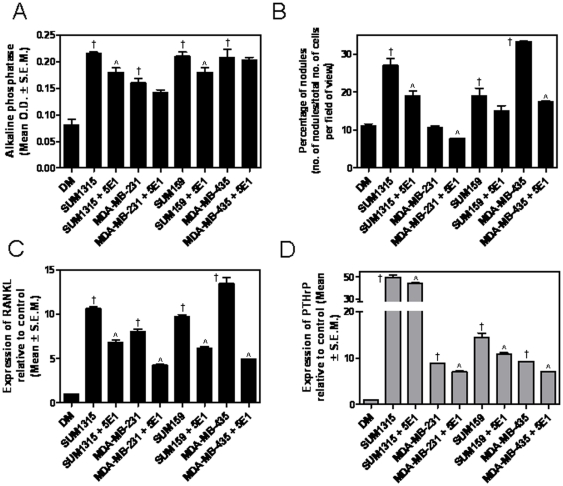
Hh ligands produced by tumor cells impacts the osteoblast differentiation and expression of RANKL and PTHrP.(A) Conditioned media from all four tumor cell lines caused a significant increase in ALP activity of MC3T3-derived osteoblasts: SUM1315 (†p = 0.0002); MDA-MB-231 (†p = 0.0035), SUM159 (†p = 0.0005), MDA-MB-435 (†p = 0.0009). Addition of the Hh neutralizing antibody, 5E1, caused a reduction in ALP activity. SUM1315+5E1 (∧p = 0.014); MDA-MB-231+5E1 (p = 0.12), SUM159+5E1 (∧p = 0.04), MDA-MB-435+5E1 (p = 0.6). (B) Tumor cell-conditioned media stimulated mineralization activity of the MC3T3-derived osteoblasts as evidenced by the numbers of mineralized nodules after Alizarin Red S staining. Nodules were counted in 12 independent fields and expressed as a percentage of the total number of cells in the field of view. SUM1315 (†p = 0.0013); MDA-MB-231 (p>0.05), SUM159 (†p = 0.018), MDA-MB-435 (†p<0.0001). Addition of the Hh neutralizing antibody caused a reduction in numbers of mineralized nodules. SUM1315+5E1 (∧p = 0.02); MDA-MB-231+5E1 (p = 0.0005), SUM159+5E1 (p = 0.17), MDA-MB-435+5E1 (p<0.0001). (C) The expression of RANKL by the differentiated MC3T3-derived osteoblasts was significantly increased in presence of tumor cell-conditioned medium. (†p = 0.0013, for all four tumor cell lines). Neutralization of the Hh ligand with the 5E1 antibody caused a reduction in the levels of RANKL expressed. SUM1315+5E1 (∧p = 0.0004); MDA-MB-231+5E1 (∧p = 0.0002), SUM159+5E1 (∧p = 0.0003), MDA-MB-435+5E1 (∧p = 0.0002). (D) The expression of PTHrP by the MC3T3-derived osteoblasts was notably greater in presence of conditioned medium from the tumor cells (p<0.0001 for all tumor cells). Neutralization of Hh ligand caused a significant decrease in the levels of PTHrP. SUM1315+5E1 (∧p = 0.04); MDA-MB-231+5E1 (∧p = 0.0001), SUM159+5E1 (∧p = 0.01), MDA-MB-435+5E1 (∧p<0.0001). The expression of RANKL and PTHrP were assessed by real time qRT-PCR after 14 days of differentiation. Data is expressed relative to control (growth medium).